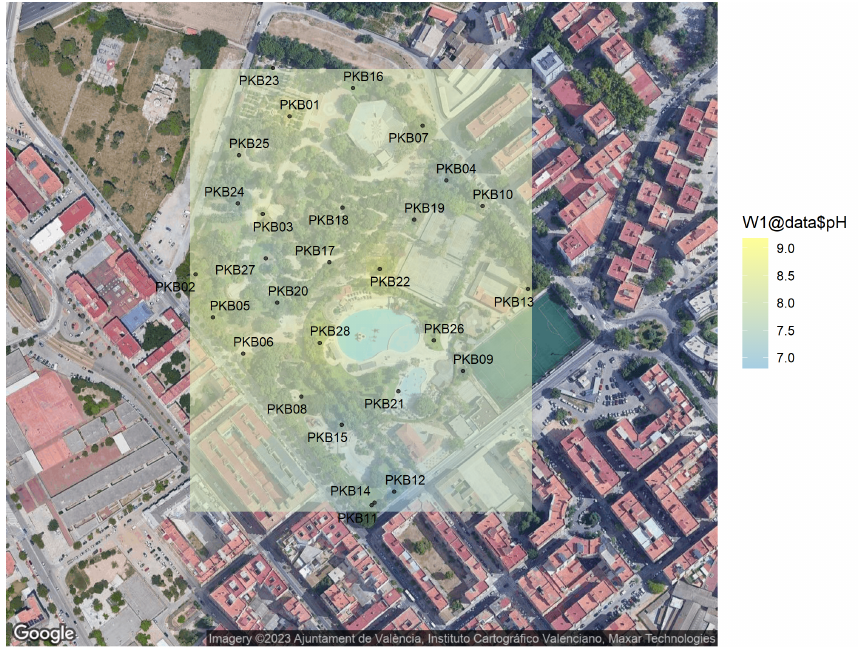
Figure 2. Kriging distribution of pH measurements (black dots) at Benicalap